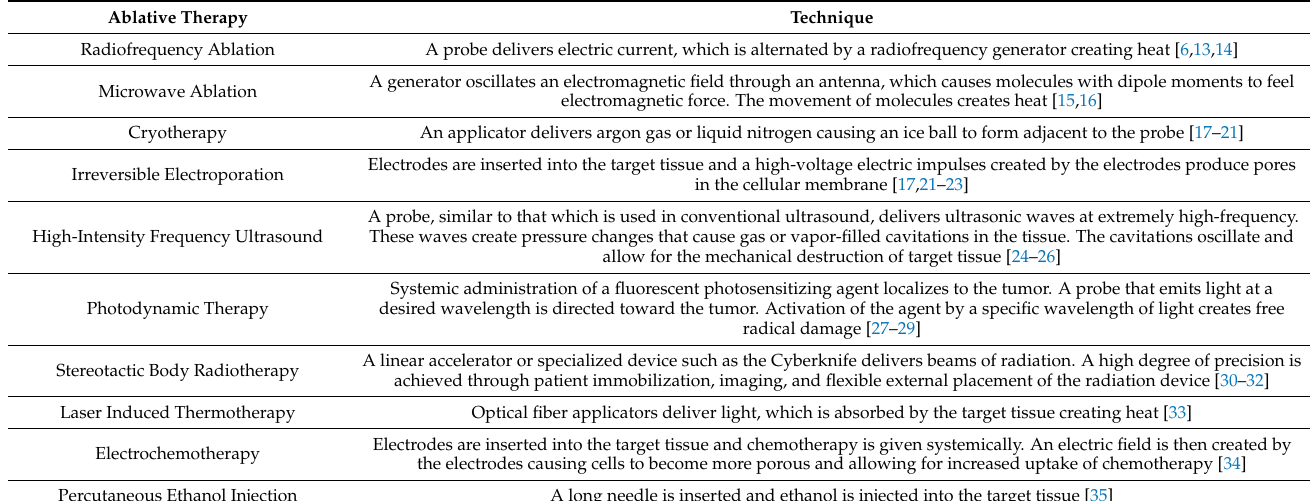
Table 1. Summary of Ablative Therapy